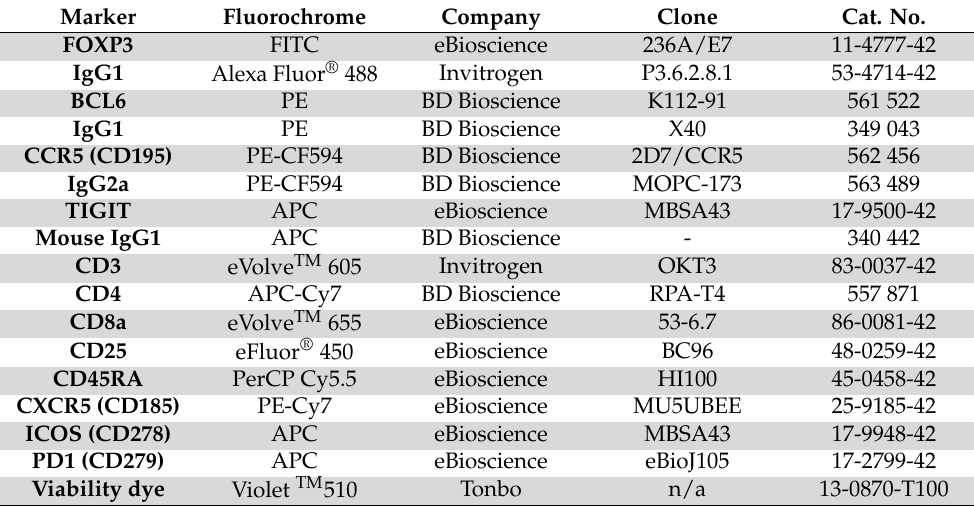
Table 1. Flow cytometry-Antibodies and their